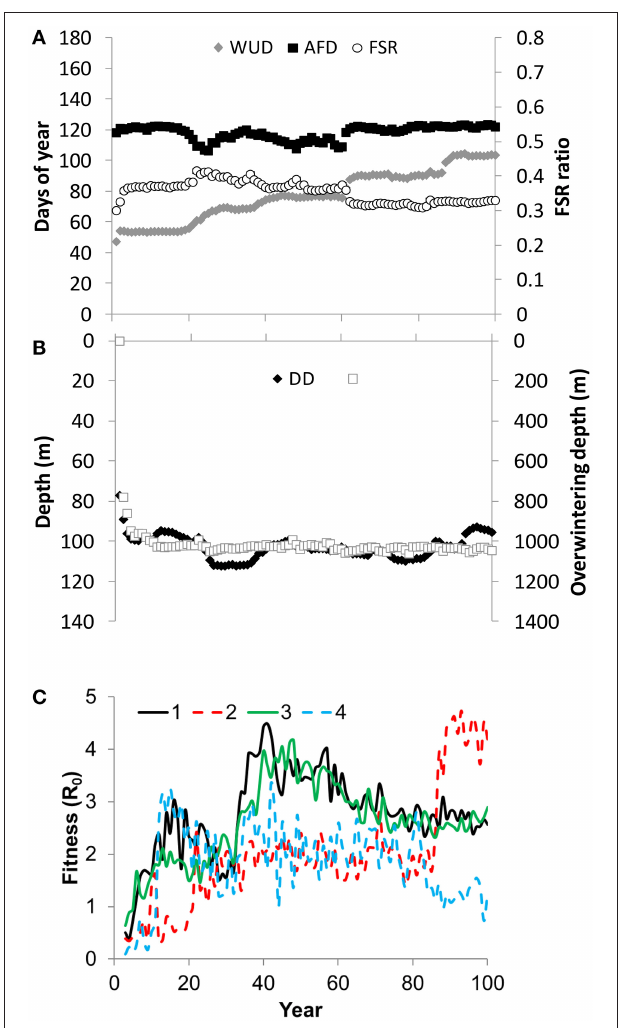
FIGURE 9 | The development over 100 years of the best replicate in simulation 7 in (A ) wake up day (WUD), allocation to fat day (AFD) and fat to soma ratio (FSR) traits, (B) the day depth (DD) and overwintering depth (OWD), and (C ) fitness (the net reproductive rate, R0) of all four replicates. Values are from end of each year.